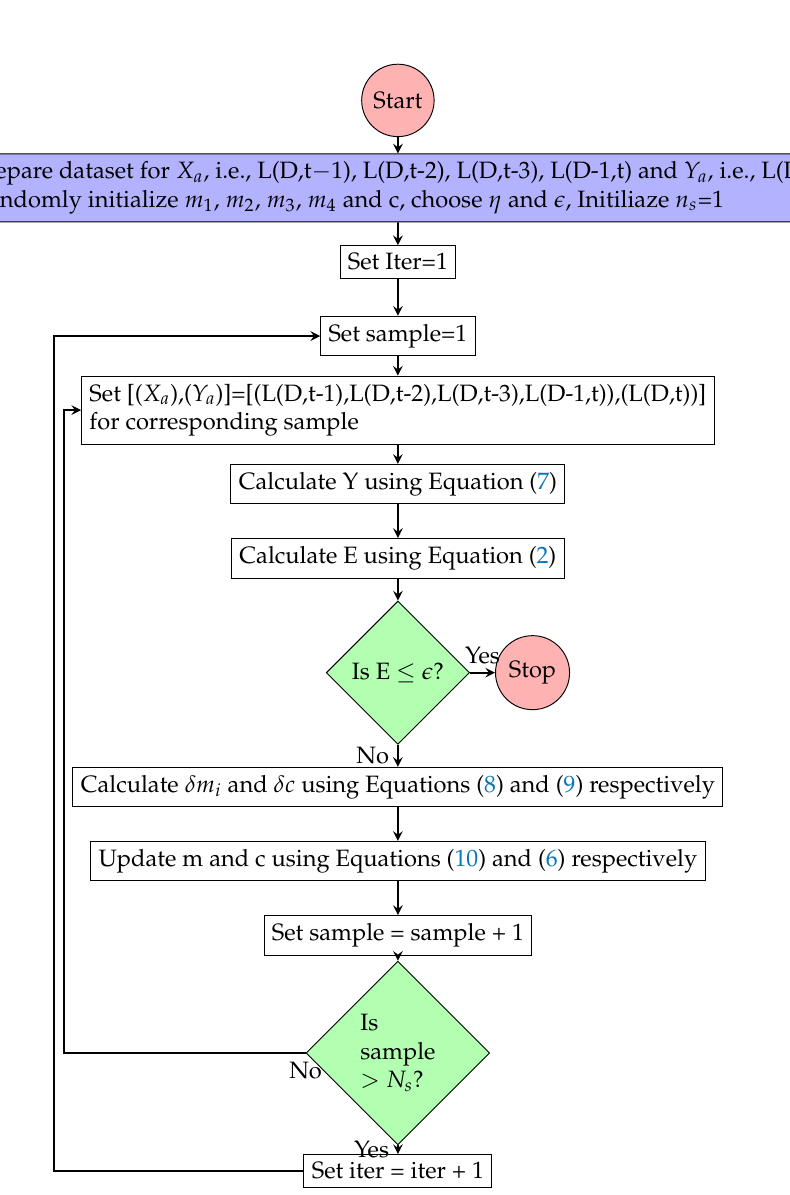
Figure 5. Multiple linear regression model training algorithm.